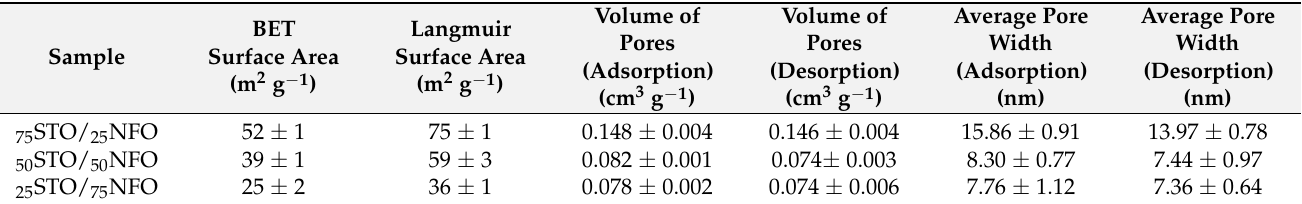
Figure 5. Nitrogen adsorption isotherms of the nanocomposites ( left ), and the corresponding average pore size distributions ( right ). Table 2. Textural characteristic of the obtained nanocomposites.